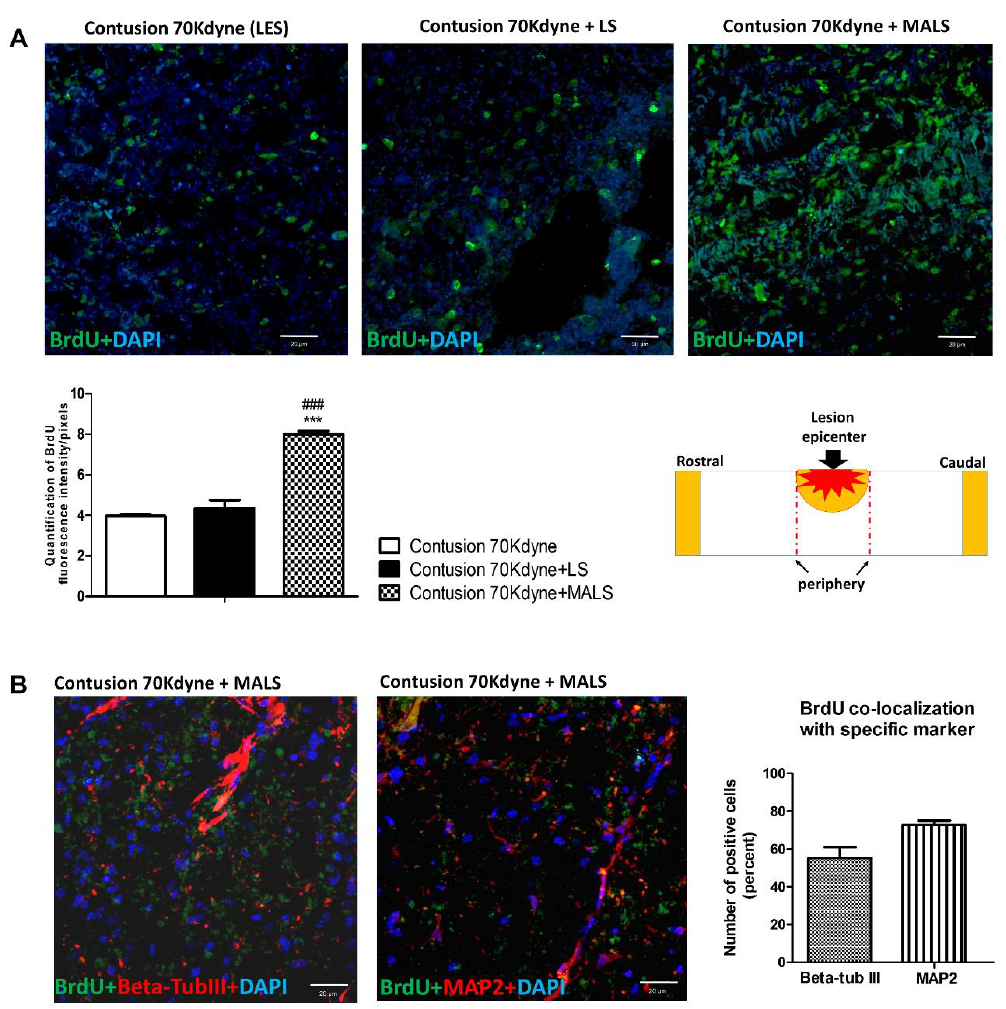
Figure 4. Transplanted MALS promotes an increase of BrdU labeled cells positive to neuronal markers. ( A ) The images show the BrdU positive cells (green) at the lesion epicenter (please see schematic representation) of contused not treated animals (LES), contused animals treated with lipoaspirate tissue, or contused animals treated with MALS tissue. Nuclei are stained with DAPI. The confocal microscope images for the spinal cord of the three groups were obtained using the same intensity, pinhole, wavelength, and thickness of the acquisition. Scale bar 20 µ m. The graph reported shows the quantification of fluorescence with reference to BrdU staining. Data is expressed as mean of nine di ff erent fields (n = 3 mice; 3 fields / mouse for each condition). Values represent mean ± SD. We determined the statistical di ff erences by means of one-way ANOVA test followed by Bonferroni’s post-test (*** p < 0.001 vs. LES; ### p < 0.001 vs. LS). ( B ) Spinal cord sections of MALS treated animals labelled with BrdU (green) were counterstained with anti-beta-tubIII or anti-Map2 antibodies (in red). The graph shows the percentage of BrdU-positive cells expressing the above neuronal markers. Data is expressed as mean of nine di ff erent fields (n = 3 mice; 3 fields / mouse). Values represent mean ±